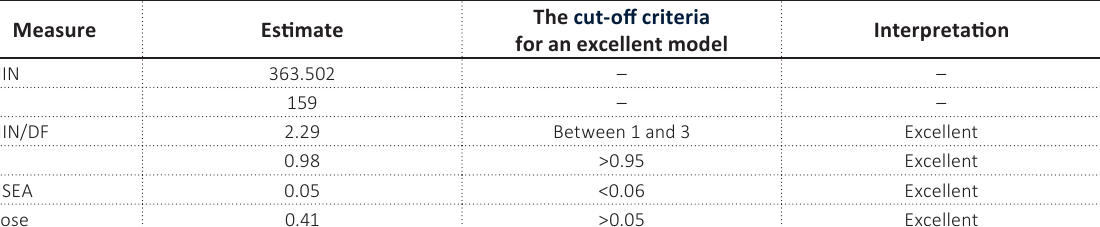
Table 1. Model fit